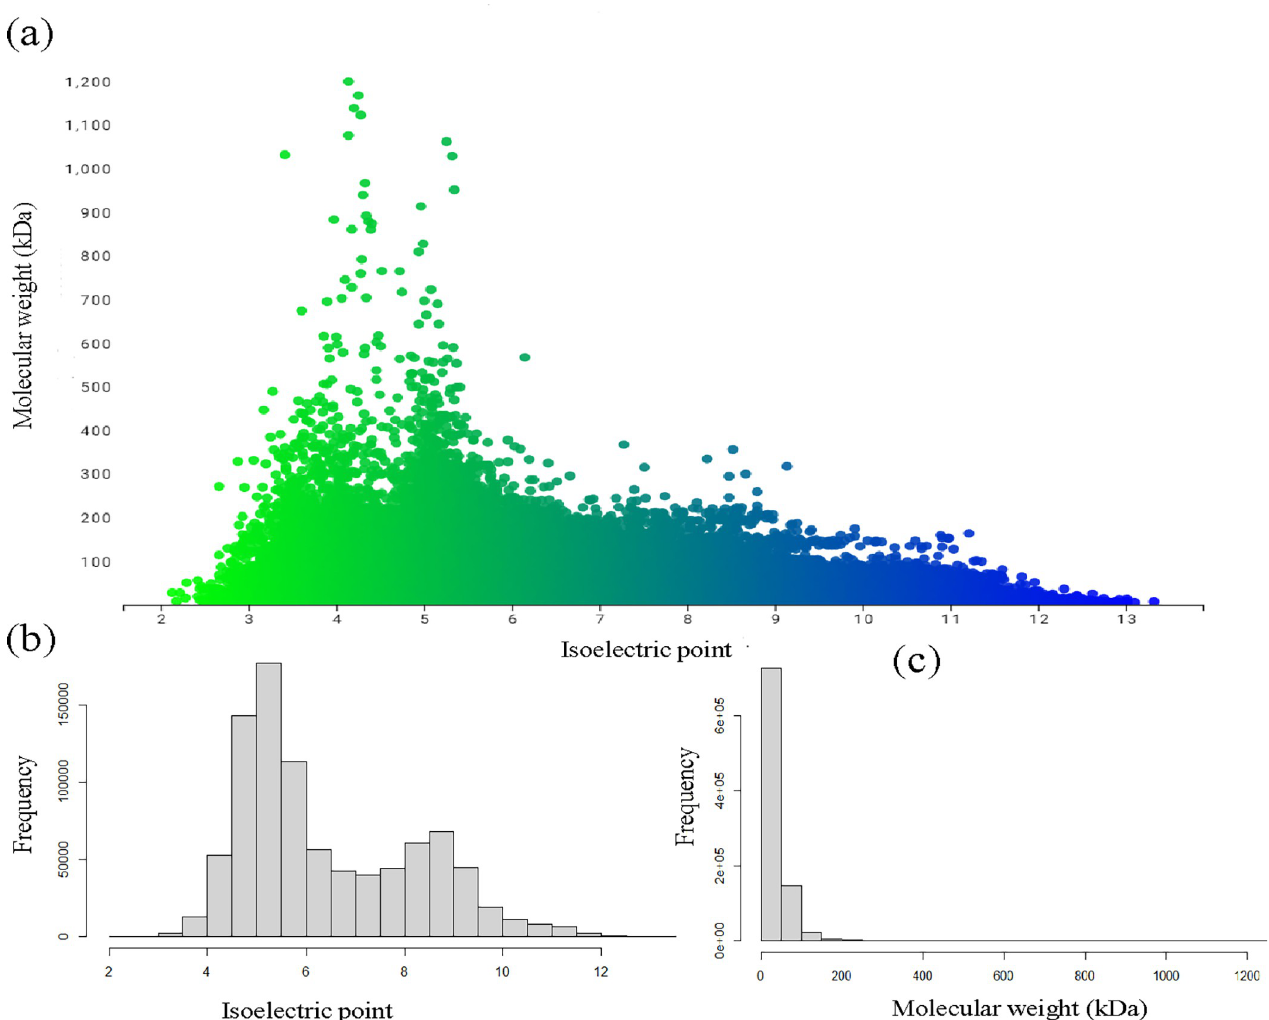
Fig 3. (a) Virtual 2D map of cyanobacterial proteome. X- axis represents isoelectric protein and Y-axis represents molecular weight (kDa). (b) Represents the frequency of isoelectric point of proteins and (c) represents the frequency of molecular weight of cyanobacterial proteins. The scatter plot was generated using scatterplot online software https://scatterplot.online/. proteome contained nonpolar amino acids and 48.525% polar amino acids. The highest and lowest abundant amino acids in different cyanobacterial species were also calculated. Prochlor- ococcus marinus contained the highest percentage of Asn (6.467%), Phe (4.966%), and Ser (7.722%) amino acids, while Candidatus gastranaerophilales contained the lowest percentage of Arg (3.349%), Gly (5.926%), Leu (8.777%), and Pro (3.274%) amino acids (Table 1). Apha- nocapsa feldmannii possessed the highest percentage of Cys (1.382%) and Arg (8.220%) amino acids, while Aphanothece minutissima contained the highest percentage of Gly (9.232%) and Pro (6.490%) amino acids. Gloeomargarita lithophora contained the highest percentage of Gln (6.325%) and Trp (1.845%) amino acids, and Candidatus gastranaerophilales encoded the highest percentage of Tyr (3.963%) and Lys (9.122%) amino acids (Table 1). The lowest per- centage of Arg (3.349%), Gly (5.926%), Leu (8.777%), and Pro (3.274%) was found in Candida- tus gastranaerophilales , while the lowest percentage of His (1.501%) and Ala (5.418%) was